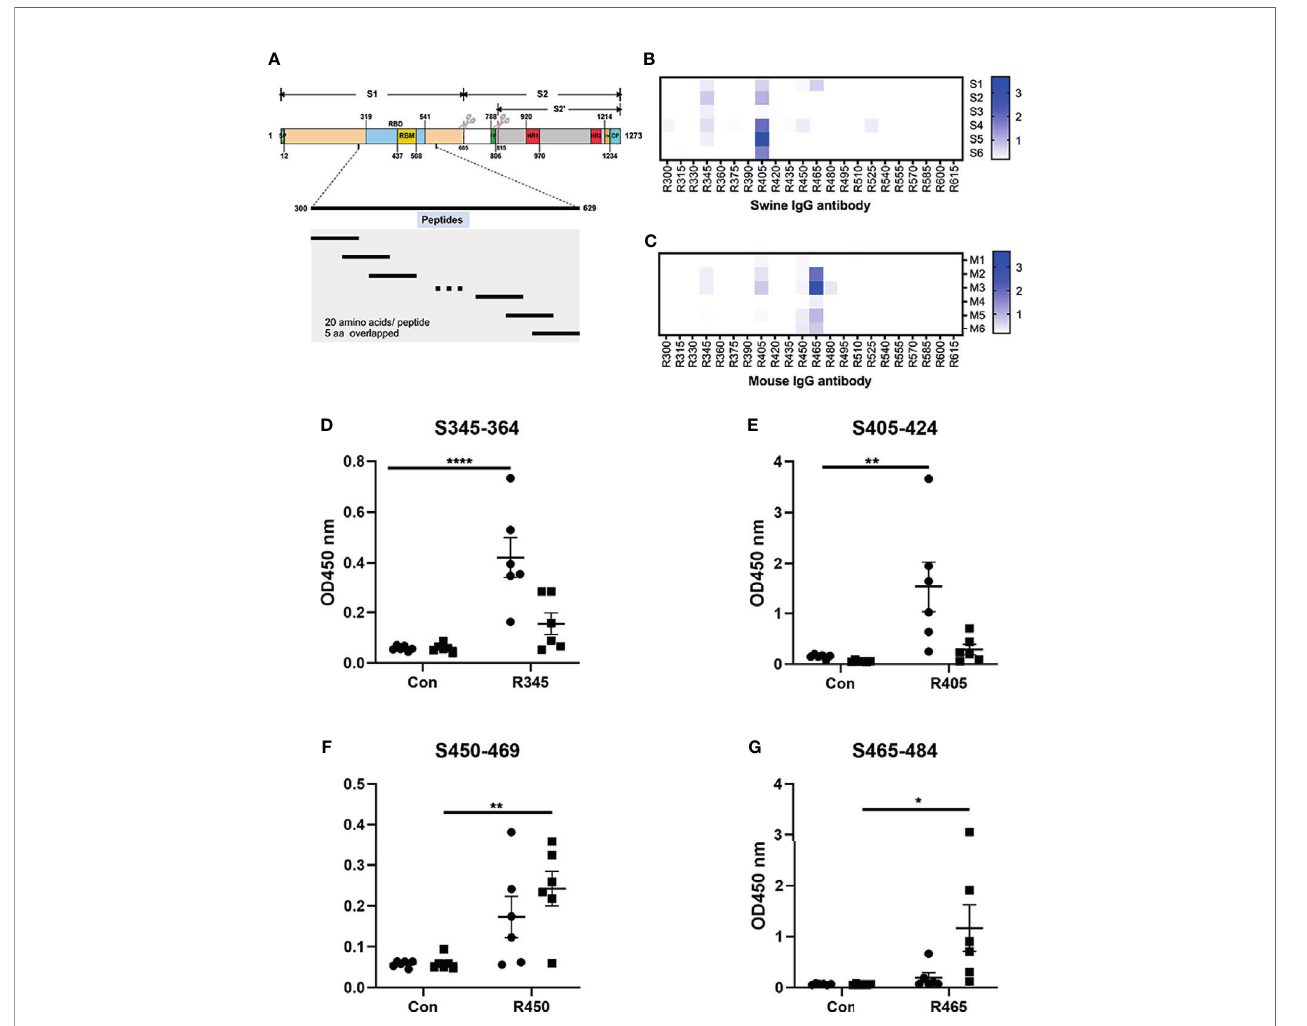
FIGURE 1 | Analysisof B-cellepitopepeptides of serum antibodies against SARS-CoV-2 RBD. (A) Schematicrepresentation of the functional domains ofS protein of SARS-CoV2 andthe overlapped peptides spanning the RBDof SARS-CoV2. The S protein consist of two functional subunits (S1 and S2). The S1/S2 cleavage sites are indicatedby the scissors. SP, signal peptide. FP, fusion peptide. HR1, heptad repeat 1. HR2, heptad repeat 2. TM,transmembrane domain. CP, cytoplasm domain. RBD, receptor-binding domain. RBM, receptor-binding motif. The aminoacid residues number in each domain indicates their position inthe S protein. (B, C) The reactivity ofsera from immunized animalswith peptide array was determined by ELISA. S1-S6, sera from swine immunized with RBD-based antigens. M1-M6, sera from mice immunized with RBD-based antigens. R300-R615, 20-mer overlapped peptides coveringthe RBD. The shadeofblue isdirectly proportional to OD450 value. (D – G) Immunodominant epitope peptides binding with the antibodies inserafromswine/mouse immunized with RBD-basedantigens. Closed circle, sera fromswine immunizedwith RBD-based antigens. Closed square, sera from miceimmunized with RBD-based antigens. Data was shownas mean ± SEM.*p< 0.05; **p < 0.01; ****p < 0.0001. Graphs were made inGraphPad Prismversion